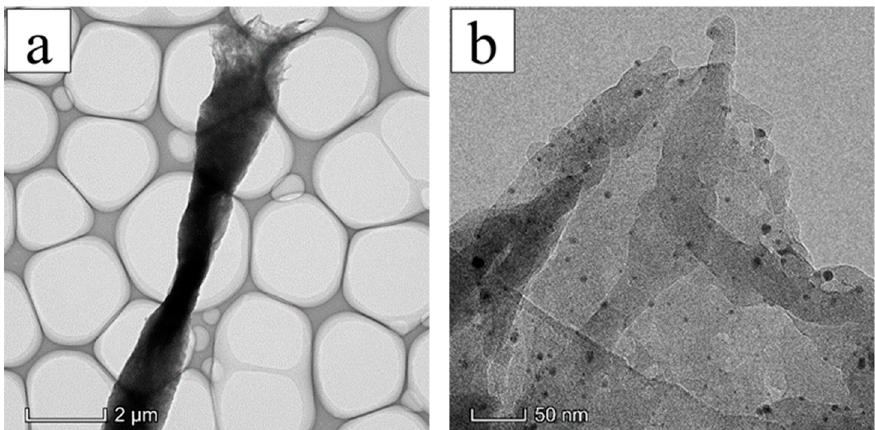
Figure 8. TEM image of AgNPs-PS side in the composite membrane: ( a ) TEM morphology of nano- fibers at low power; ( b ) TEM morphology of nanofibers at high power.